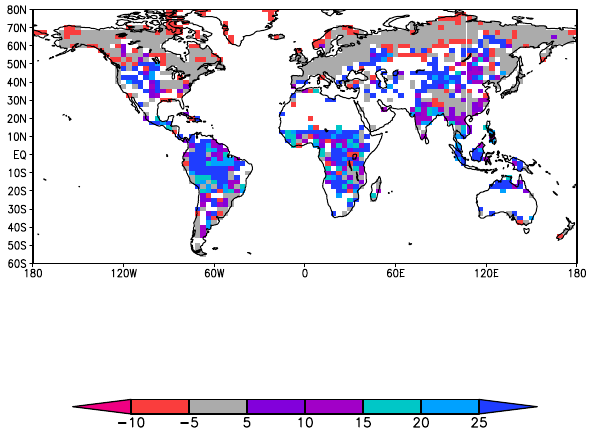
Fig. 3. Relative changes in gross primary productivity (GPP, expressed in %) from simulations without to with acclimation of V cmax and J max at the end of the 21st century, estimated as (GPPacclim-GPPnon-acclim)*100/GPPnon acclim (Mercado et al., unpublished). Results are equilibrium simulations with cli- mate warming as 2 ◦ C compared to present day, using a coupled IMOGEN-JULES set-up (Huntingford et al., 2010). Values below − 10% are excluded. Areas indicated in white colour are mostly dry and with low productivity. In addition, in some (productive) areas the model predicts a change in vegetation composition which com- plicates the analysis of acclimation effects. These were thus also excluded from